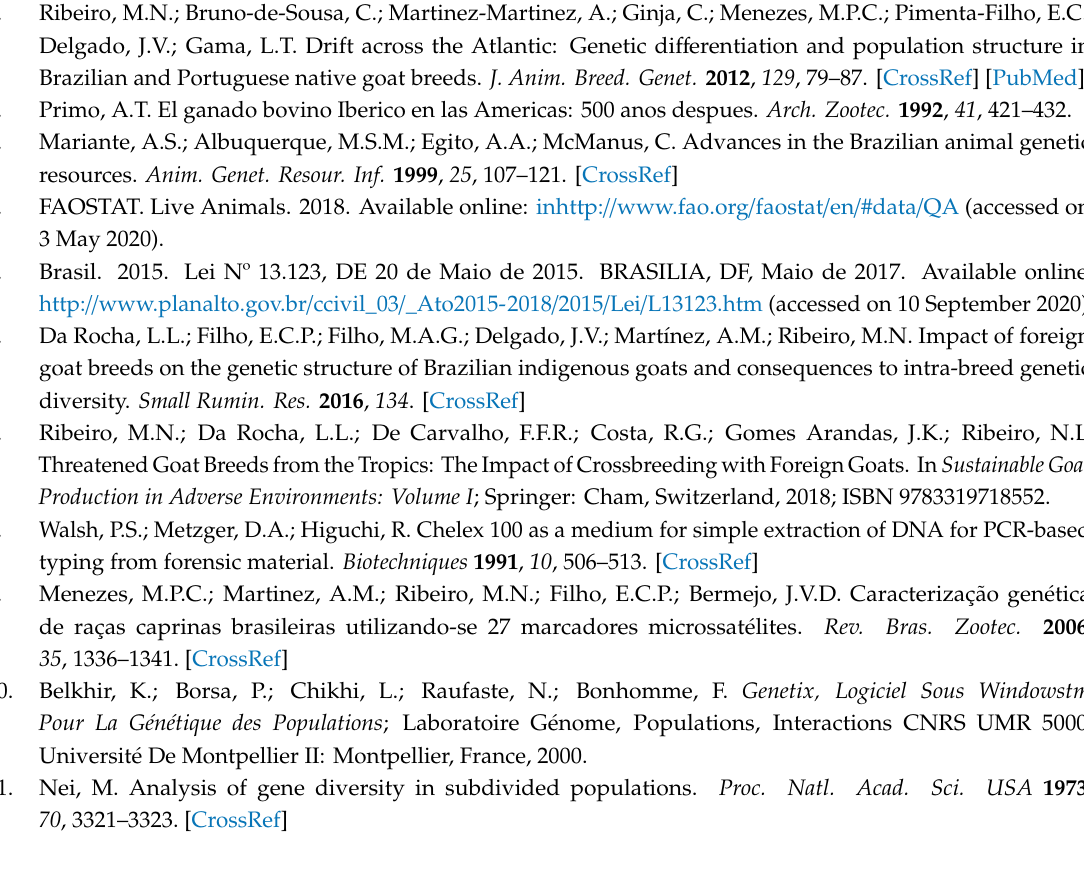
Figure S1: Brazilian goat breeds, Table S1: Microsatellites analyzed, fragment sizes, fluorochromes, and the respective sequences (direct and reverse) of the